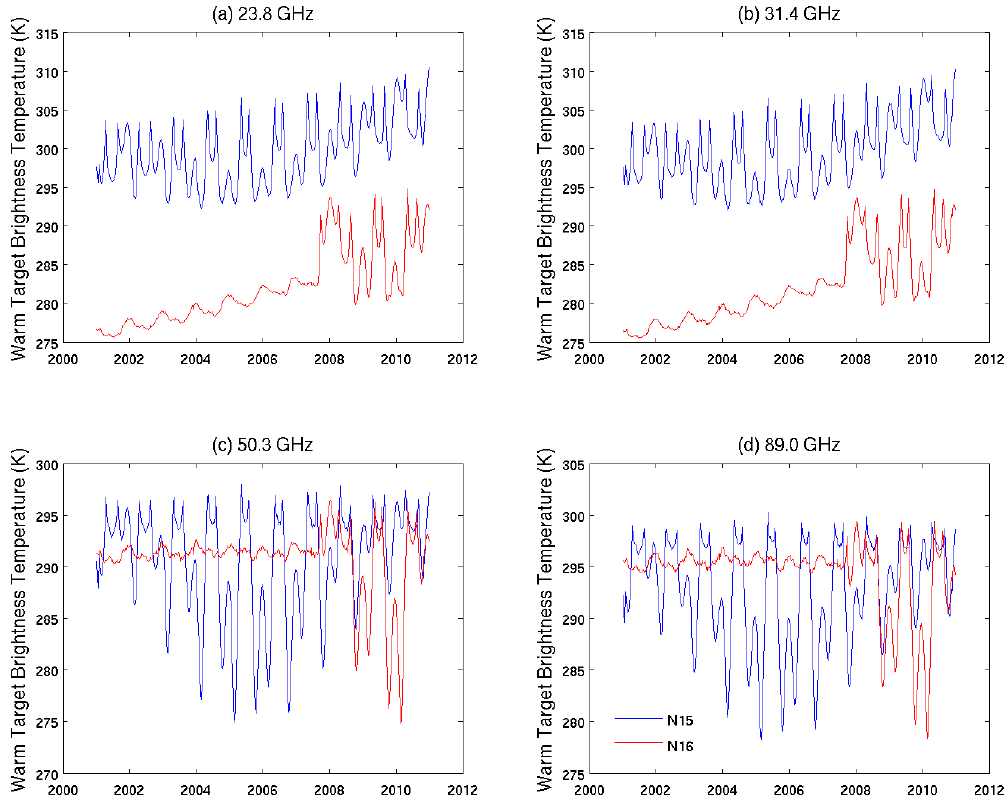
Figure 4. Warm target temperature variation between AMSU-A onboard N15 and N16, from their operational time through 2010 for ( a ) 23.8, ( b ) 31.4, ( c ) 50.3, and ( d ) 89 GHz. Note: the only observations during their SNO period are shown to decrease the sampling.